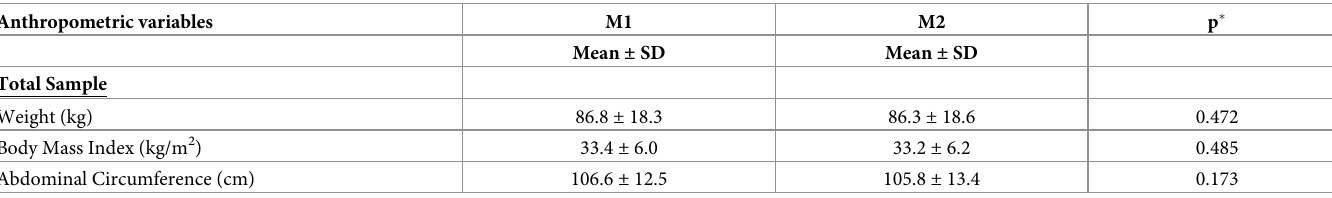
Table 2. Anthropometric factors between M1 and M2 of patients with metabolic syndrome, Porto Alegre, Brazil (n = 63). Anthropometric